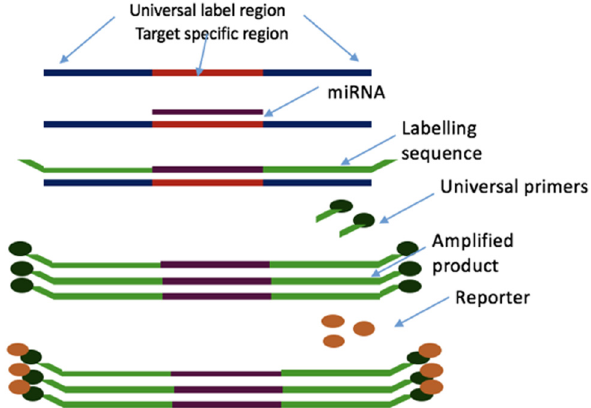
Figure 1: FirePlex ™ microRNA assay. This allows the pro fi ling of up to 65 target miRNAs of one ’ s choice simultaneously. It can be utilized to pro fi le microRNAs directly from bio fl uids or puri fi ed RNA.